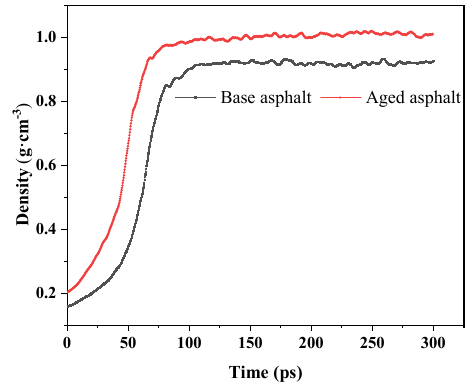
Figure 10. Density changing during simulation.